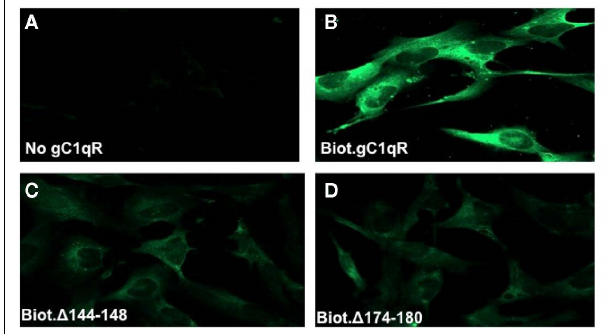
FIGURE 6 | Immunofluorescence studies. Human Brain microvascular endothelial cells (HBr-MIVECs) were first grown on cover slips and the attached cells reacted first with PBS containing 0.1% BSA and 1% heated human serum to block unreacted sites, followed by Alexa-488 conjugated streptavidin or neutravidin. After incubation, the cells were fixed for 10min with 3.7% (v/v) formalin, and then examined by 3D imaging using deconvolution microscopy. (A) is non-specific control and shows the image of cells reacted with Alexa-conjugated streptavidin (ACS) only. (B–D) show images of cells that were first treated with either biotinylatedWT-gC1q-R, or deletion mutants 144–148 or 174–180 and then stained with